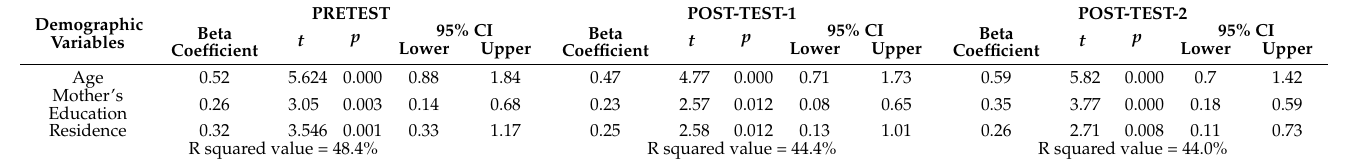
Table 6. Regression Analysis of SBP with Demographic Variables among Study Group.